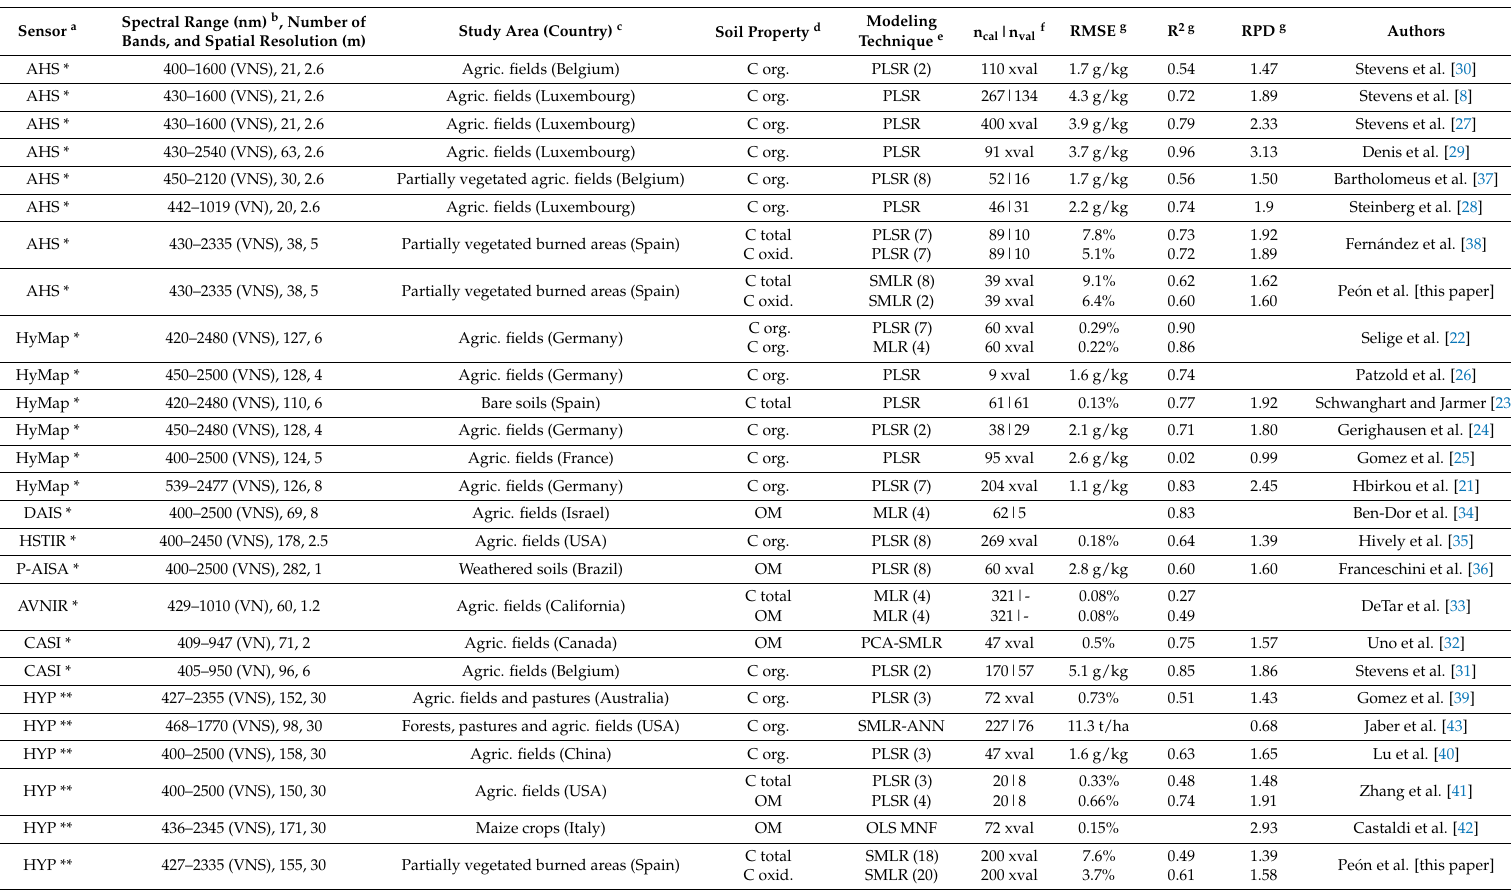
Table 4. Validation statistics of previous studies for SOC/organic matter estimation using airborne and satellite hyperspectral data in the VIS–NIR–SWIR region. Sensor